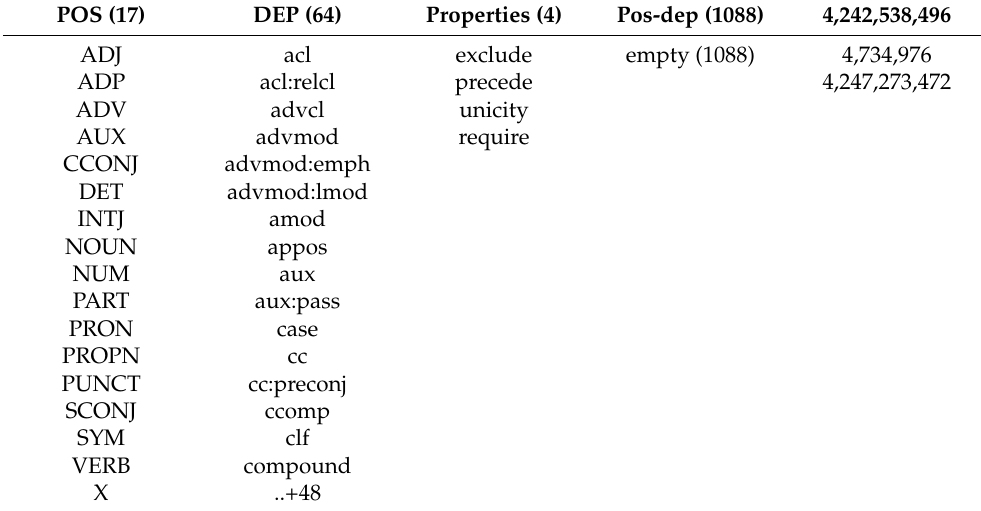
Table 1. Representation of the elements involved in the production of a U - FPGr for syntactic